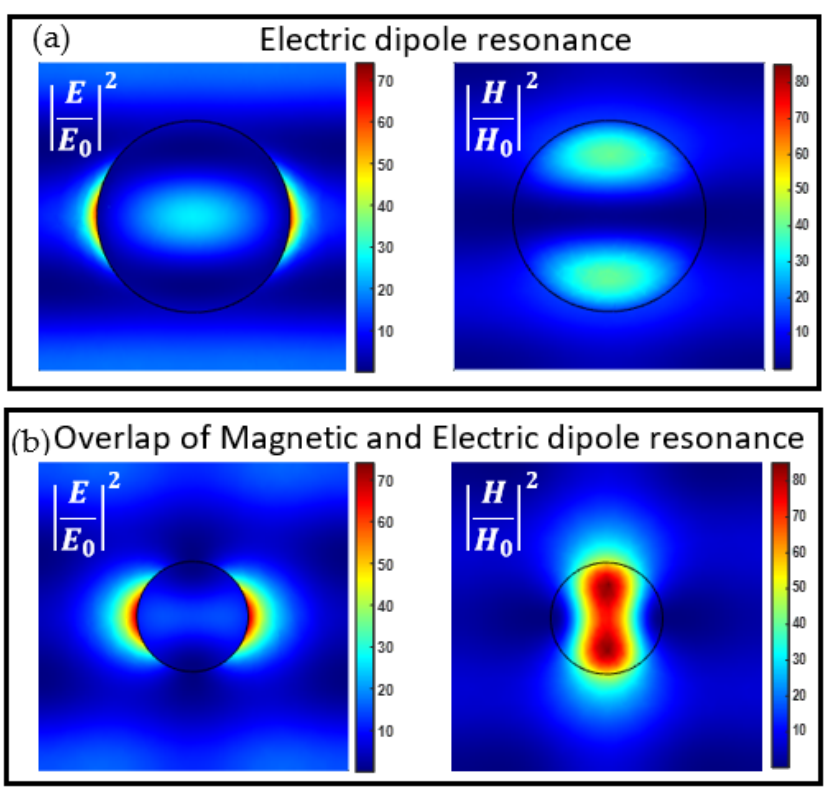
Figure 5. Electric and magnetic field maps at λ = 650 nm in a cut plane through the center of the NS (circle in black) for ( a ) a resonant cylinder (D = 200 nm, h = 60 nm) featuring electric dipole resonance and ( b ) a resonant cylinder (D = 160 nm, h = 120 nm) featuring an overlap of the electric and magnetic dipole resonance.